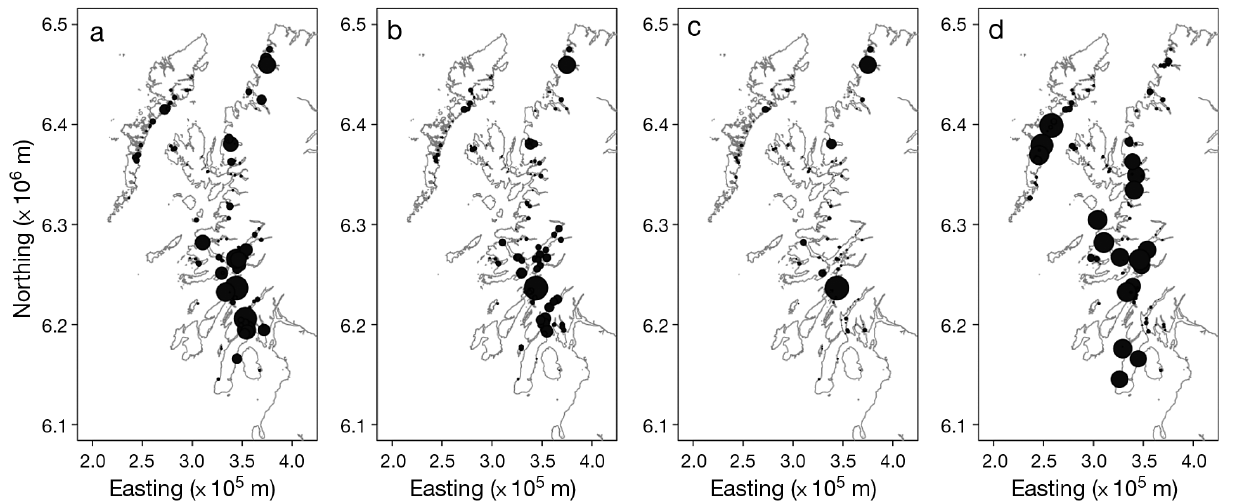
Fig. 3. Mean connectivity by site. (a) Relative mean influx for each site (sum of incoming connection probabilities). (b) Relative mean outflux (sum of outgoing connection probabilities). (c) Site self-infection probability. (d) Site betweenness (number of shortest paths a site lies on, as computed using Dijkstra’s